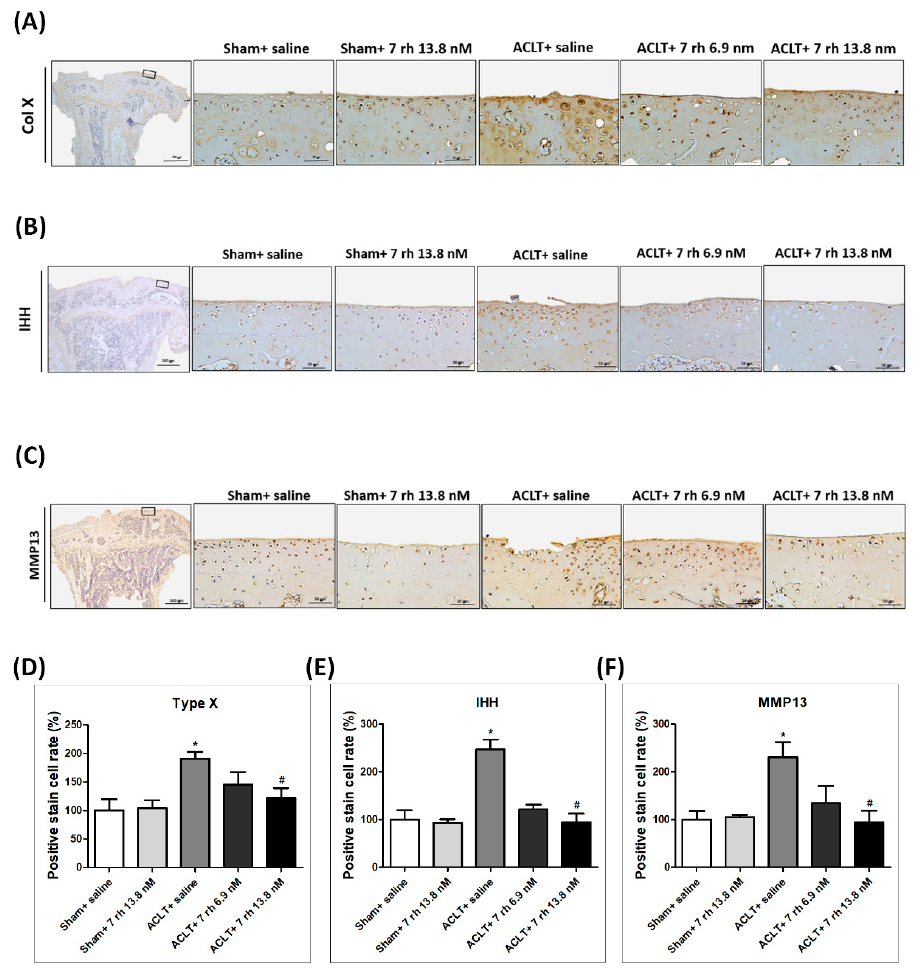
Figure 4. Intra-articular injections of 7 rh reduced the chondrocyte hypertrophic differentiation in anterior cruciate ligament transection (ACLT)-induced osteoarthritis (OA) cartilage. ( A ) The representative micrographs of immunolocalized type X collagen (Col X) in articular cartilage of the sham control groups (sham + saline and sham + 7 rh 13.8 nM), ACLT, and two 7 rh treating groups. ( B ) The representative micrographs of immunolocalized Indian hedgehog (IHH). ( C ) The representative micrographs of immunolocalized matrix metallopeptidase 13 (MMP13). ( D ) Quantitative analysis of the immunohistochemically (IHC) staining of Col X. ( E ) Quantitative analysis of the IHC staining of IHH. ( F ) Quantitative analysis of the immunohistochemical IHC of MMP13. In quantitative analysis,